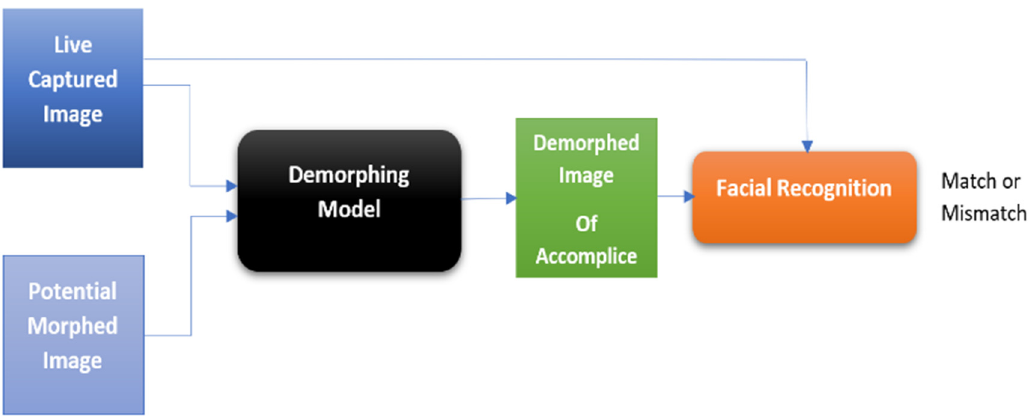
Figure 3. Basic methodology of a demorphing morph attack detection model.